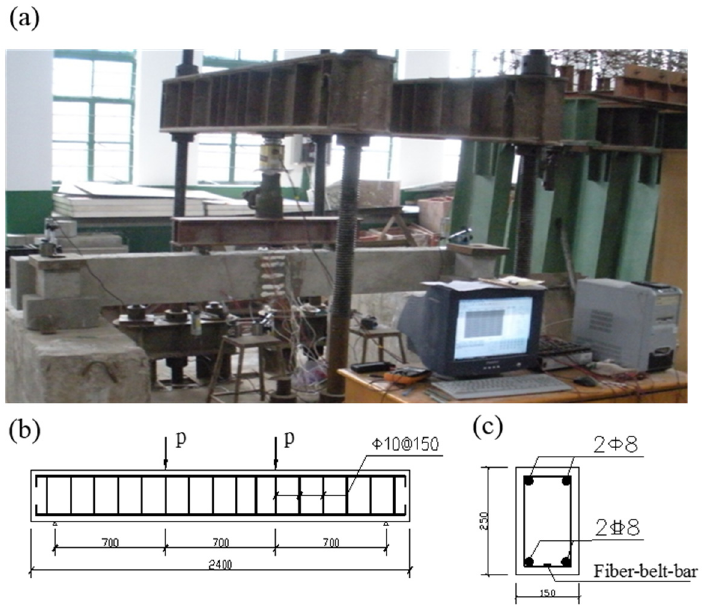
Figure 3. Loading test of the beam. ( a ) Beam loading device diagram, ( b ) Specimen size and reinforcement diagram, ( c ) Reinforcement diagram of cross section of specimen.